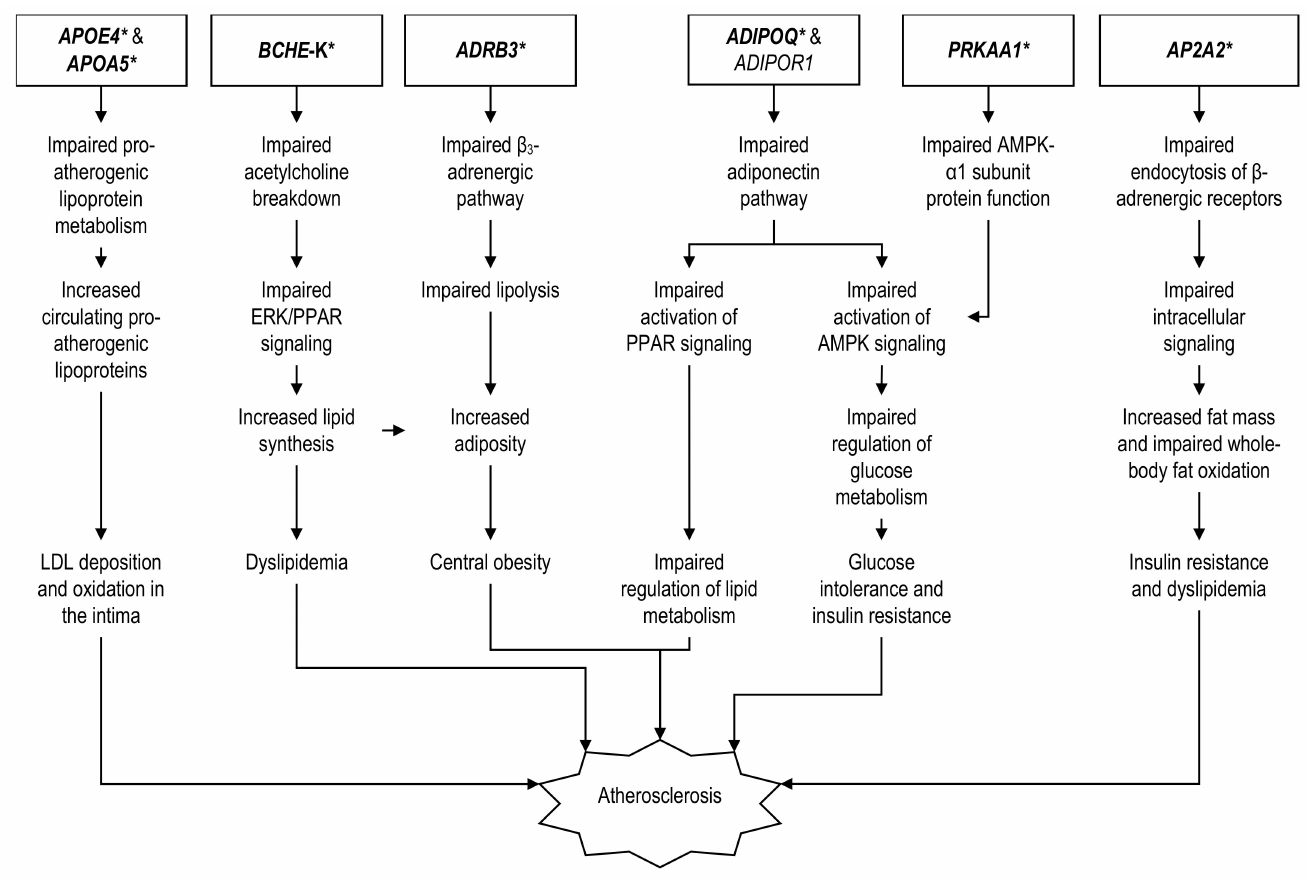
Figure 1. Proposed mechanisms of genes related to energy and lipoprotein metabolisms associated with CHD in the T2D Asian population. * Significant association with CHD exclusive in T2D Asians but not T2D Caucasians. Abbreviations: AMPK (5 (cid:48) adenosine monophosphate-activated protein kinase), ERK (extracellular signal-regulated kinase), LDL (low-density lipoprotein), PPAR (peroxisome proliferation-activated